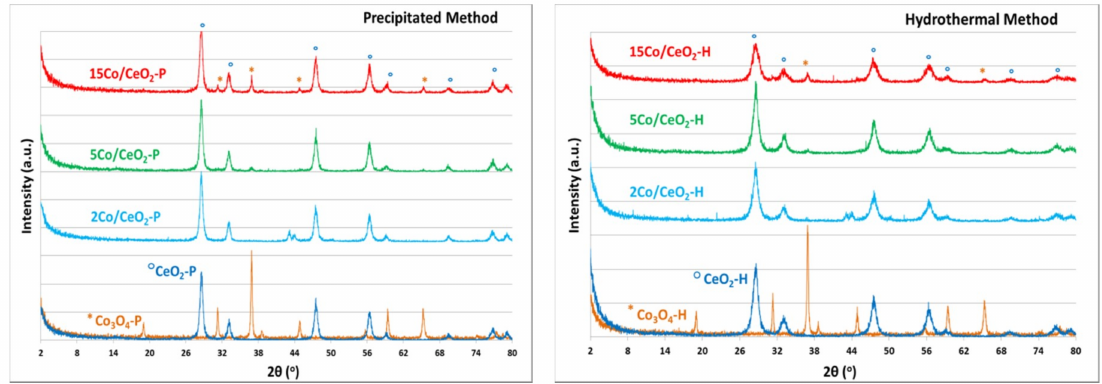
Figure 1. XRD patterns of CeO 2 , Co 3 O 4 and x Co/CeO 2 prepared following the ( a ) precipitation method; and ( b ) the hydrothermal method. ( x : 2, 5 or 15 wt% Co